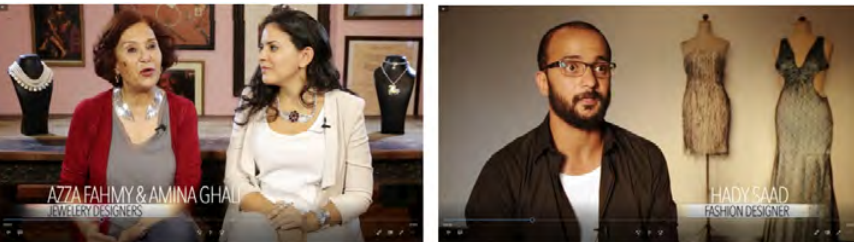
Figure 17. Some public figures in Egypt (New Egypt Old Friends, 2016)